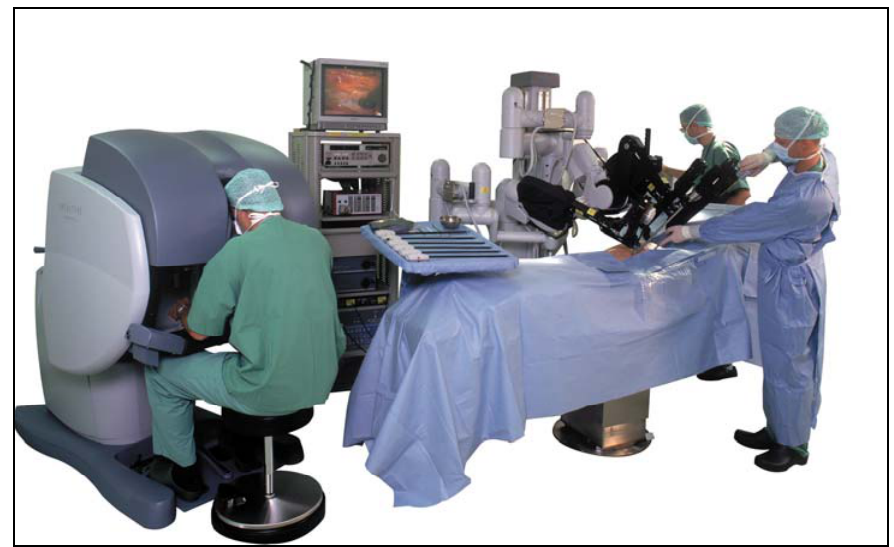
FIGURE 1 . The daVinci ® robotic system: surgical console, vision cart, and patient-side surgical cart. Photo courtesy of Intuitive Surgical, Sunnyvale,